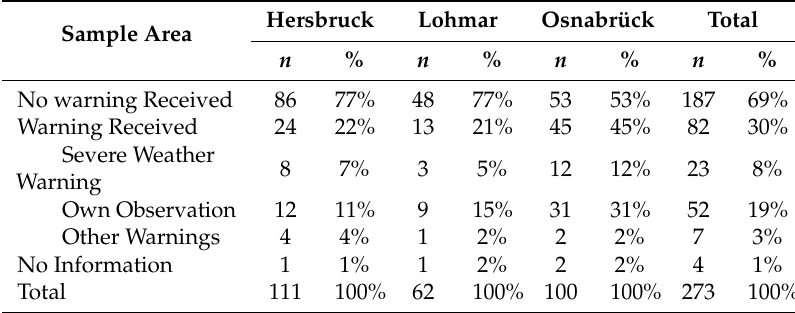
Table 3. Number and fraction of households who received or did not receive an early warning prior to the pluvial flooding